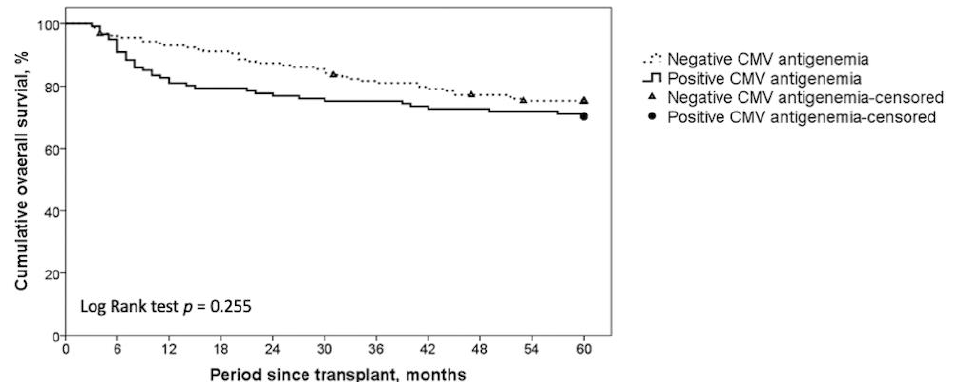
Figure 1. Kaplan – Meier method for five-year cumulative recurrence-free survival (RFS) depend- ing on CMV antigenemia positivity and negativity. Positive CMV antigenemia group showed a significantly superior five-year RFS.